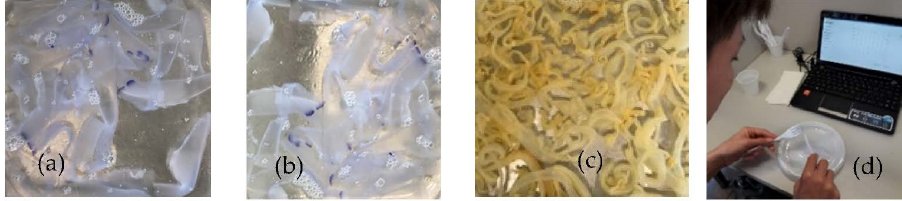
Figure 1. JF strip samples for DA test. ( a ): JF-DW-HT; ( b ): JF-FR-DW; ( c ): JF from China; ( d ): A panelist performing DA test.